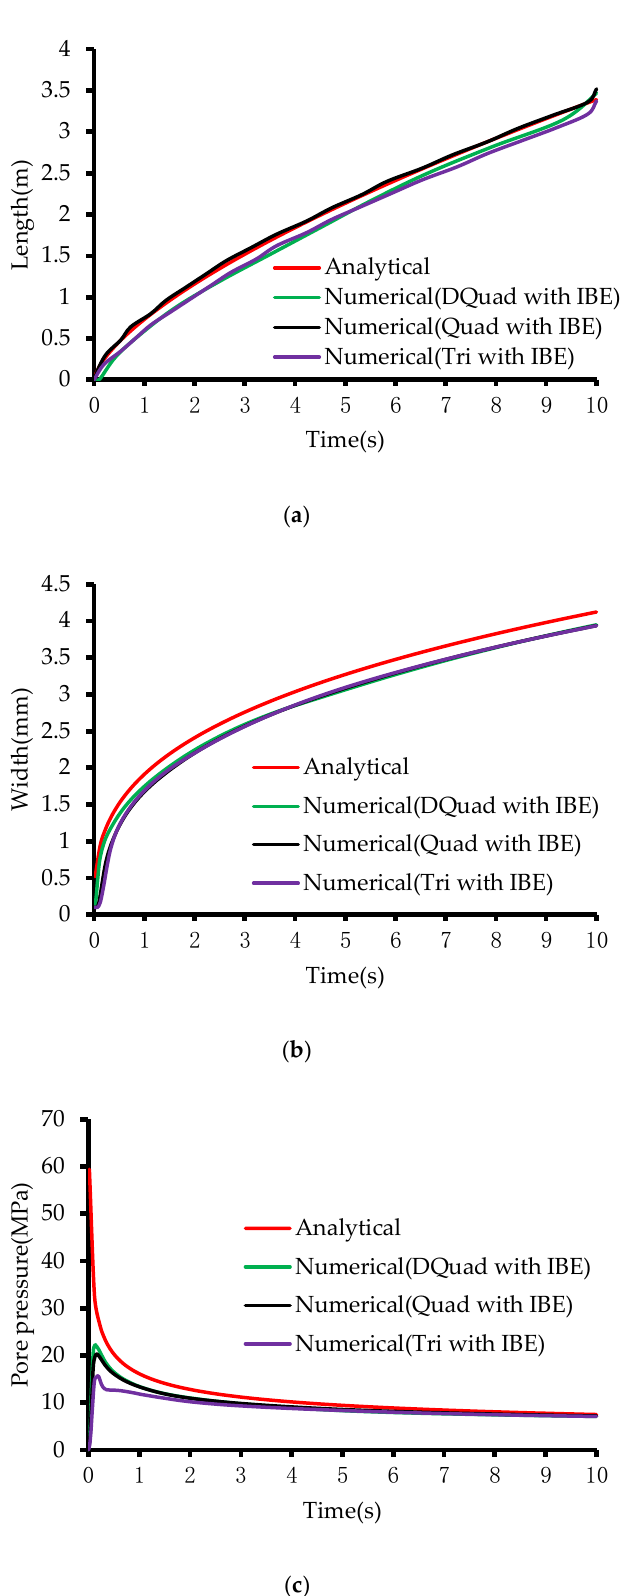
Figure 7. Comparison between numerical results with di ff erent mesh types and analytical results of zero toughness. ( a ) Variation of fracture length with time; ( b ) fracture width at the injection point; ( c ) pore pressure at the injection